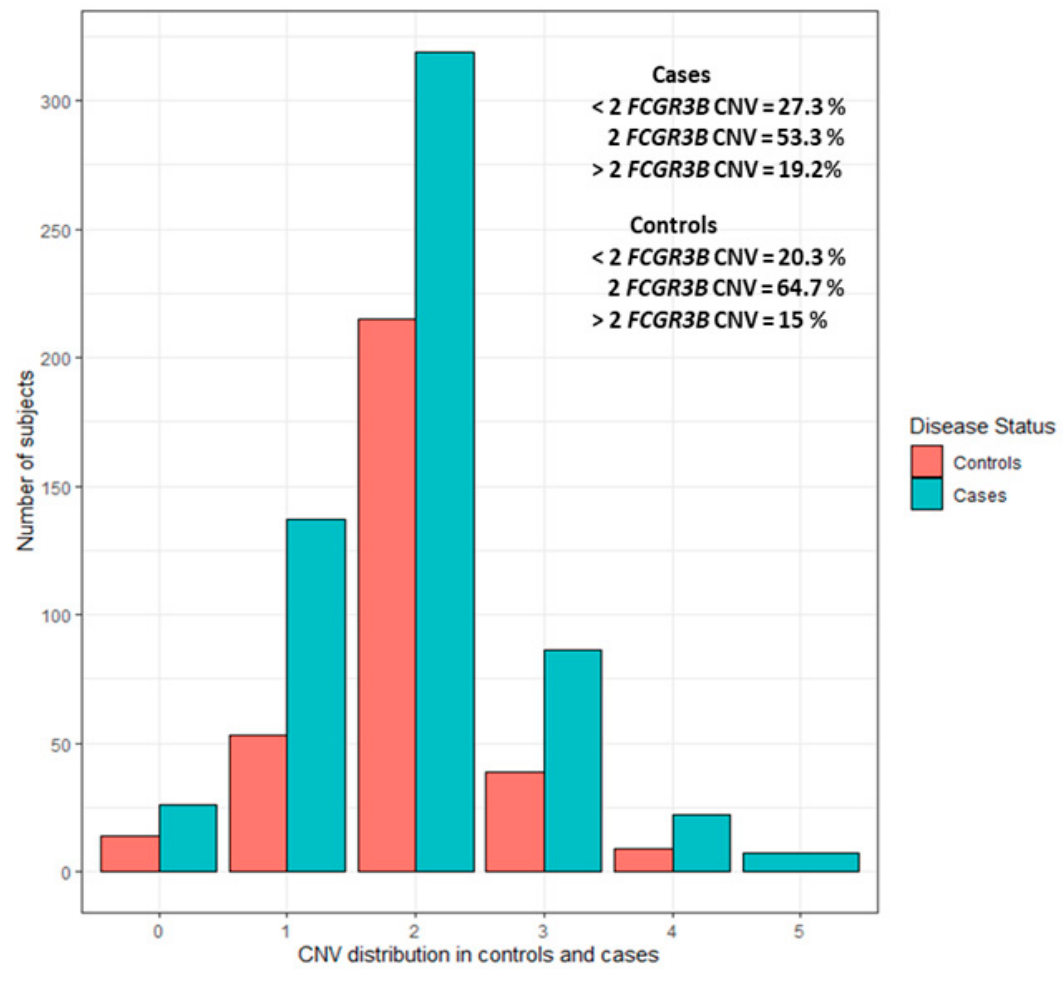
Figure 1. CNV distribution in cases and controls separately.